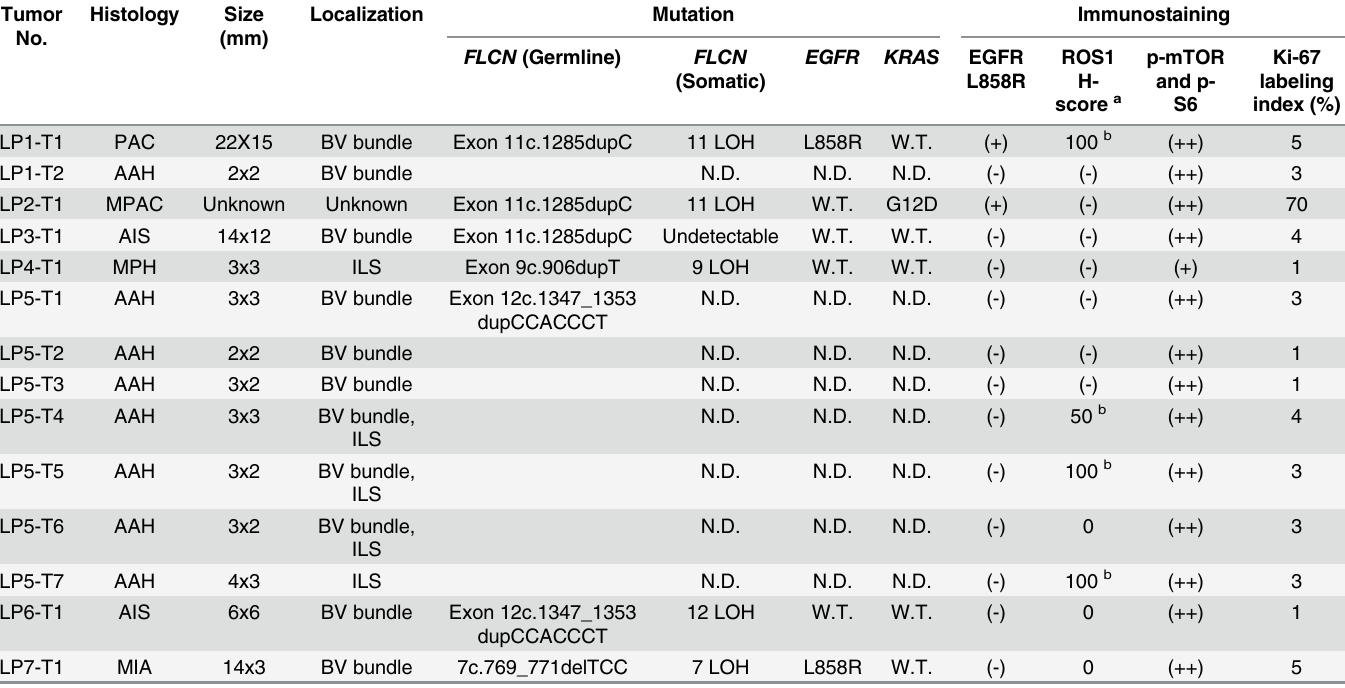
Table 2. Summary of histology, gene mutations and immunostaining. Tumor